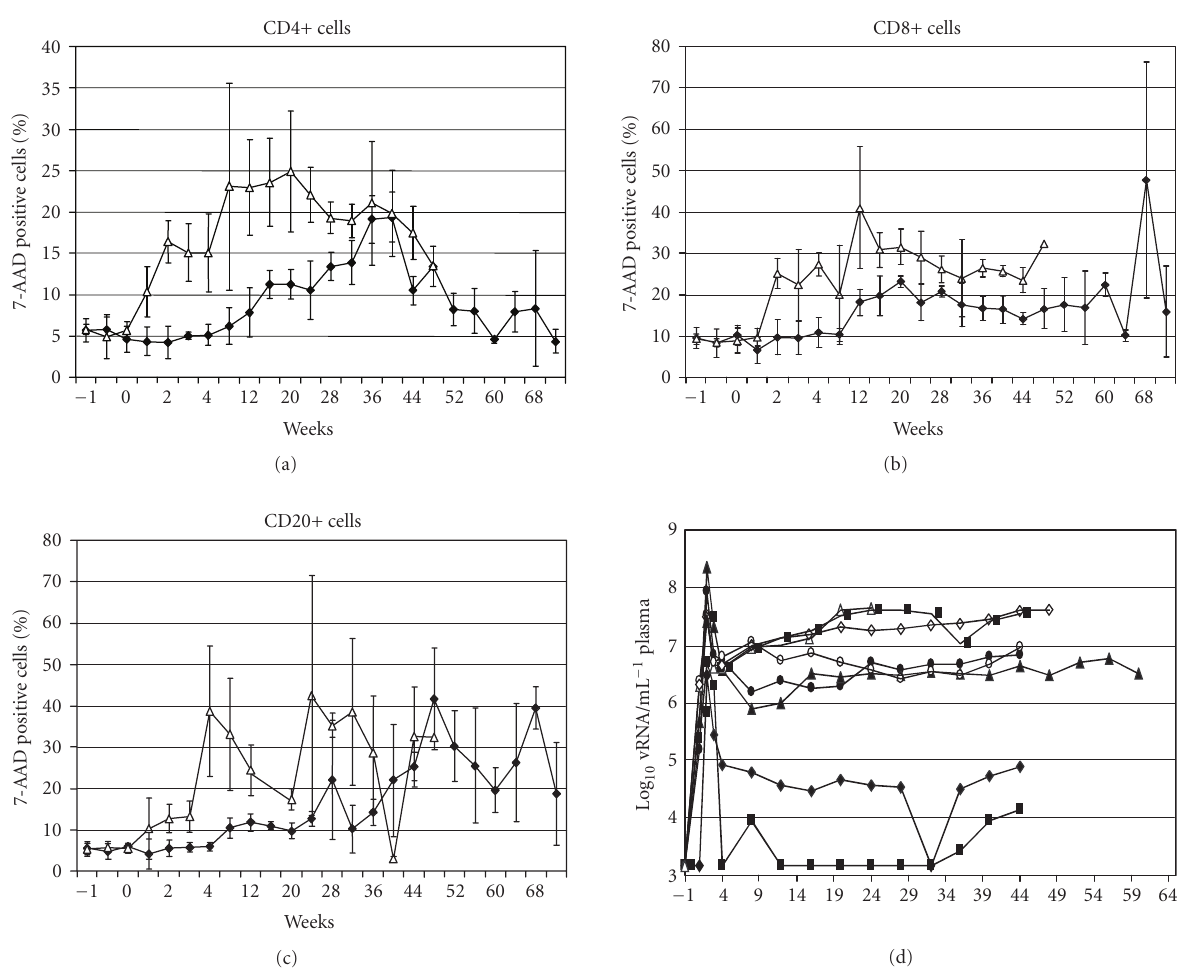
Figure 2: Inhibition of cell death and reduced plasma vRNA after treatment with anti-FasL. Macaque PBMC specimens were collected 1 week before ( − 1) and at regular intervals after SIVmac239 infection (that occurred at week 0). The animals were treated with RNOK203 or a control IgG1 (Sigma #I-3889). Panels (a)–(c) show the proportion of dying (positive for 7-AAD staining) lymphocytes in the CD4+, CD8+, or CD20+ subsets. Open symbols represent the average values among four macaques treated with control IgG. Closed symbols represent the average values among four macaques treated with anti-FasL. Error bars show the standard error of the mean for each time point. The absolute cell counts for panels (a)–(c) are summarized in Table 2. Panel D shows the plasma SIVmac vRNA levels for each animal determined by b- DNA assays (conducted by Bayer Diagnostics, Emeryville, CA). The two animals with lowest set-point RNA were also the two that survived longest (Figure 4). Open symbols represent control animals and closed symbols represent macaques treated with anti-FasL. The limit of detection for this assay was 10 3 vRNA copies per mL of